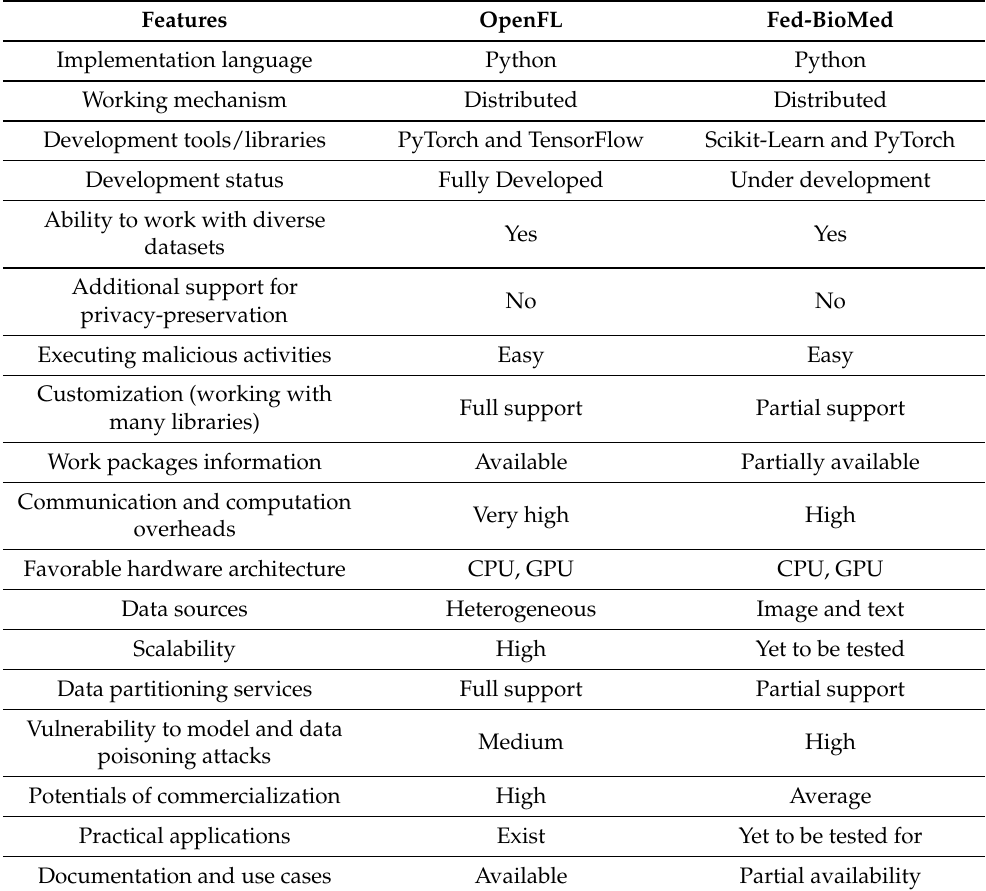
Table 4. Detailed comparison of medical implementation of Fl